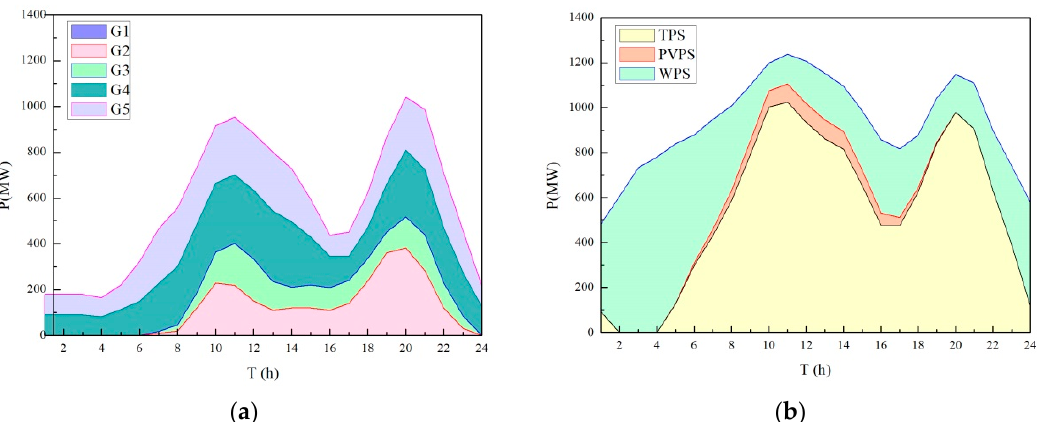
Figure 9. Output State of Each Thermoelectric Unit and Load Supply within the Park in Scenario 4.